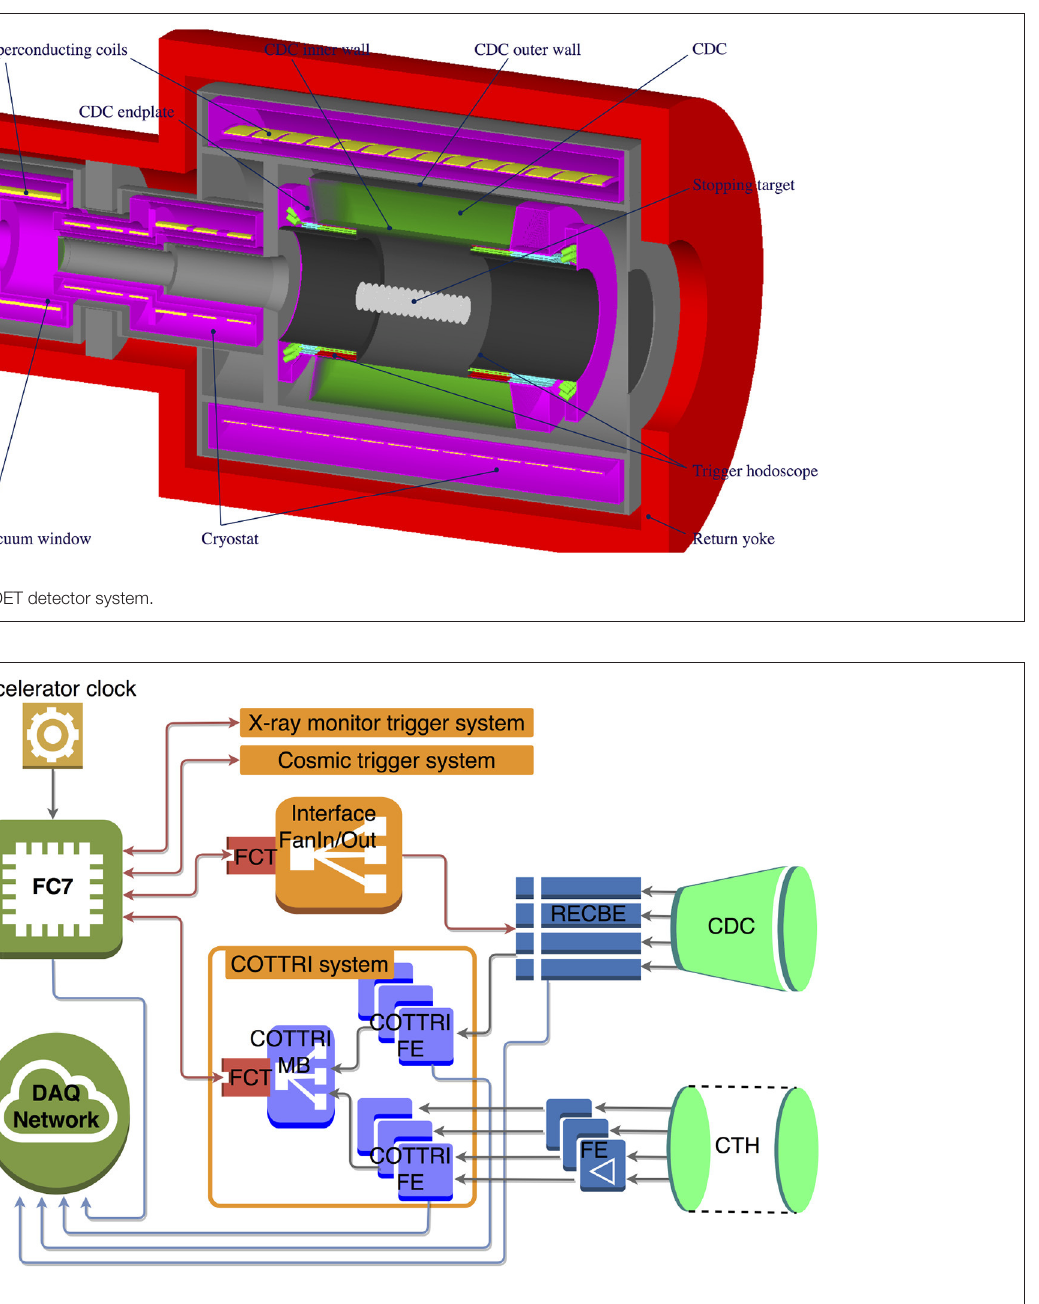
FIGURE 5 | The design of CyDET trigger and readout